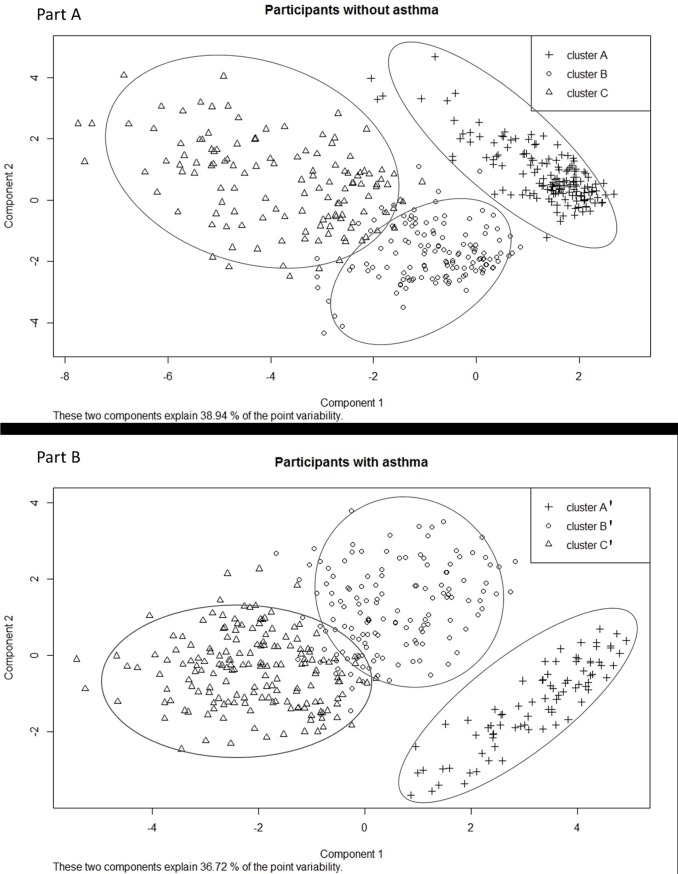
Visualization of the clusters for participants without asthma (Part A) and participants with asthma (Part B) on the first factorial map.